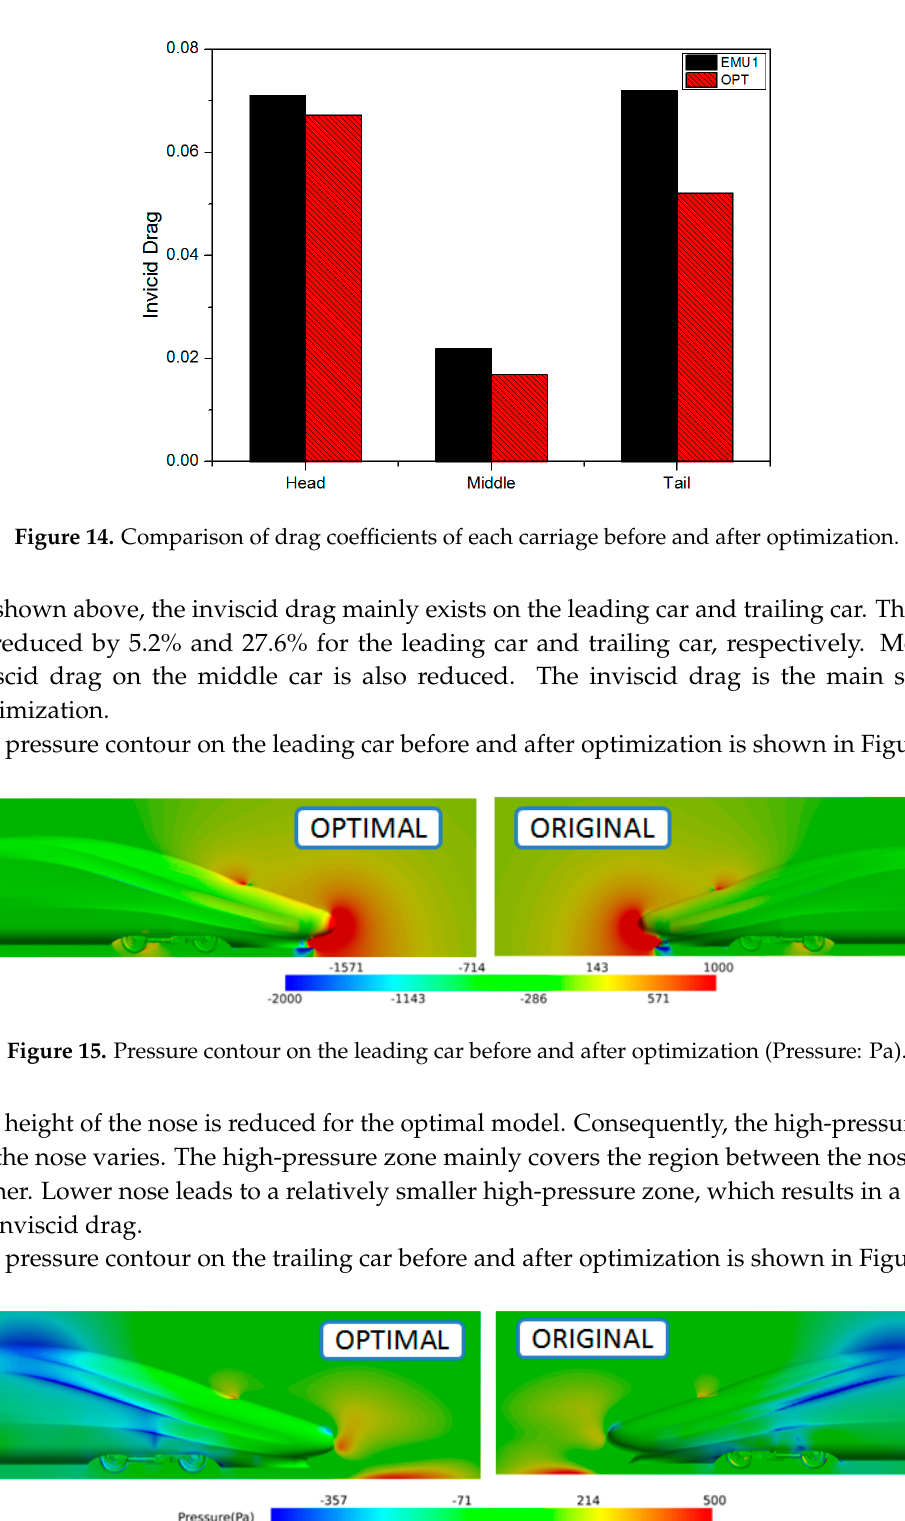
Figure 16. Pressure contour on the trailing car before and after optimization.